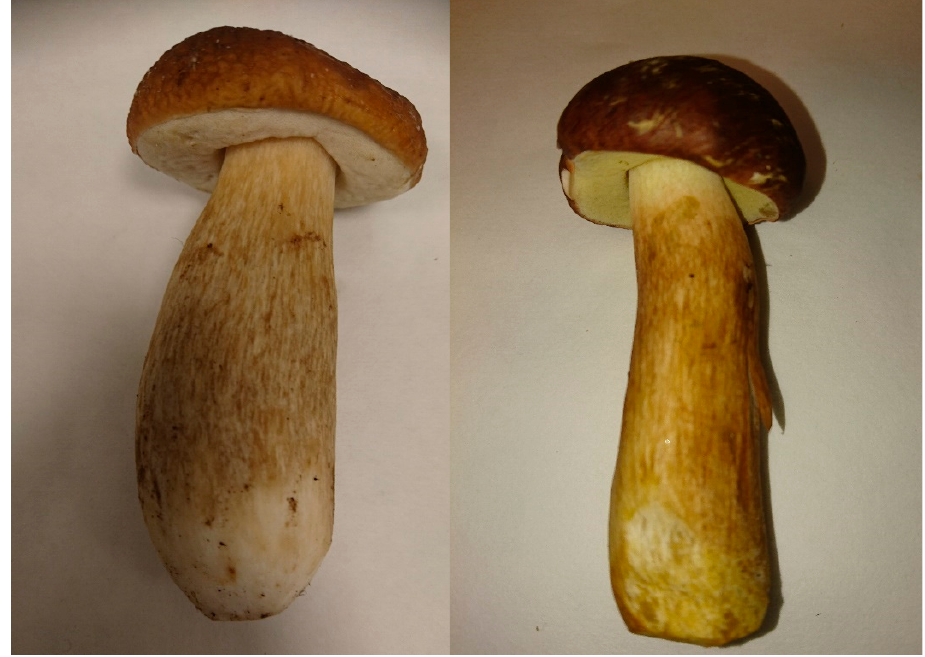
Figure 1. Boletus edulis ( left ) and Xerocomus badius ( right ).